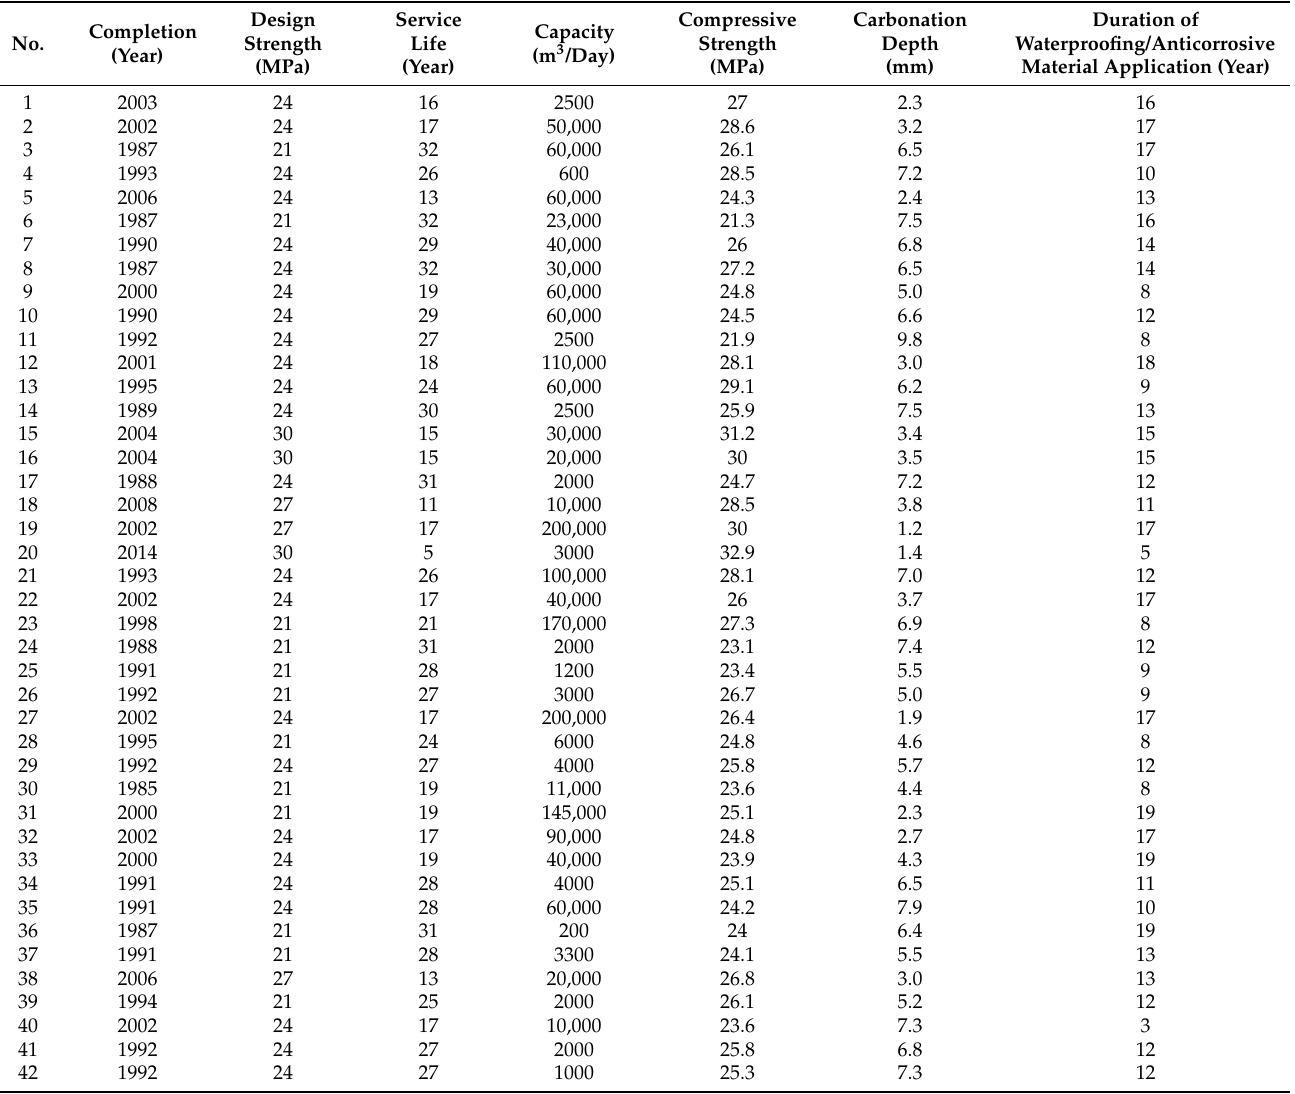
Table 3. Carbonation depth measurement results for each water supply